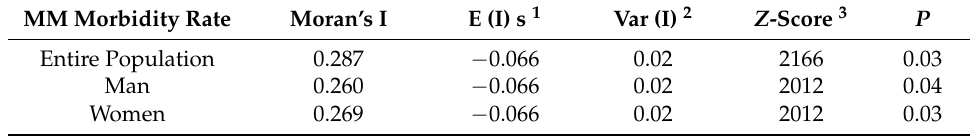
Table 1. Global Moran’s I statistics for the cumulative MM morbidity rate in Poland. MM Morbidity Rate